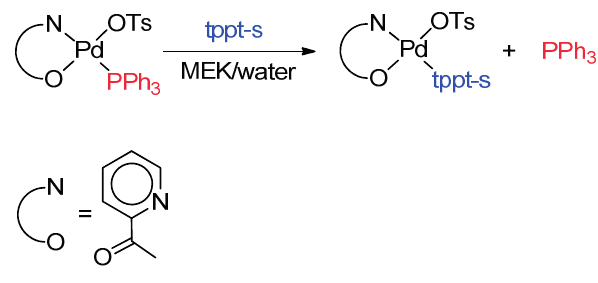
Figure 7. Water-soluble catalyst precursor with tppt-s